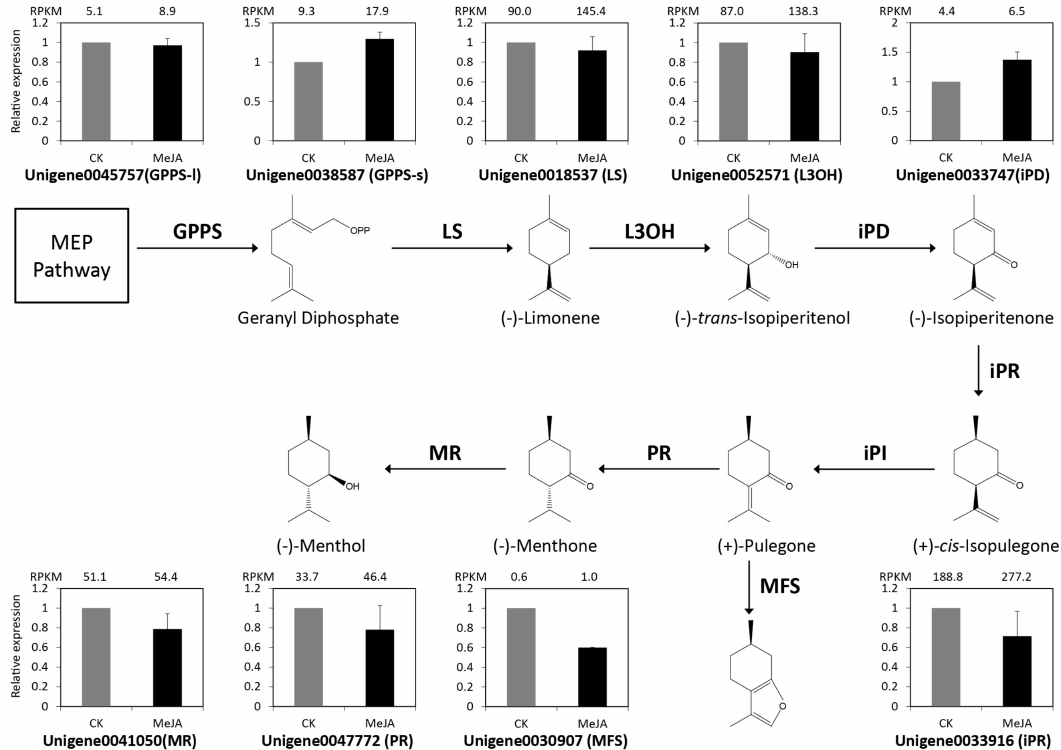
Figure 7. Expression validations of 9 menthol biosynthetic genes in control and MeJA-treated samples using qRT-PCR. The RPKM values obtained from RNA-Seq data are indicated on the top of each graph. GPPS, Geranyl diphosphate synthase; LS, ( − )-Limonene synthase; L3OH, ( − )-Limonene-3-hydroxylase; iPD, ( − )-trans-Isopiperitenol dehydrogenase; iPR, ( − )-Isopiperitenone reductase; iPI, (+)- cis -Isopulegone isomerase; PR, (+)-Pulegone reductase; MFS, Menthofuran synthase; MR, ( − )-Menthol